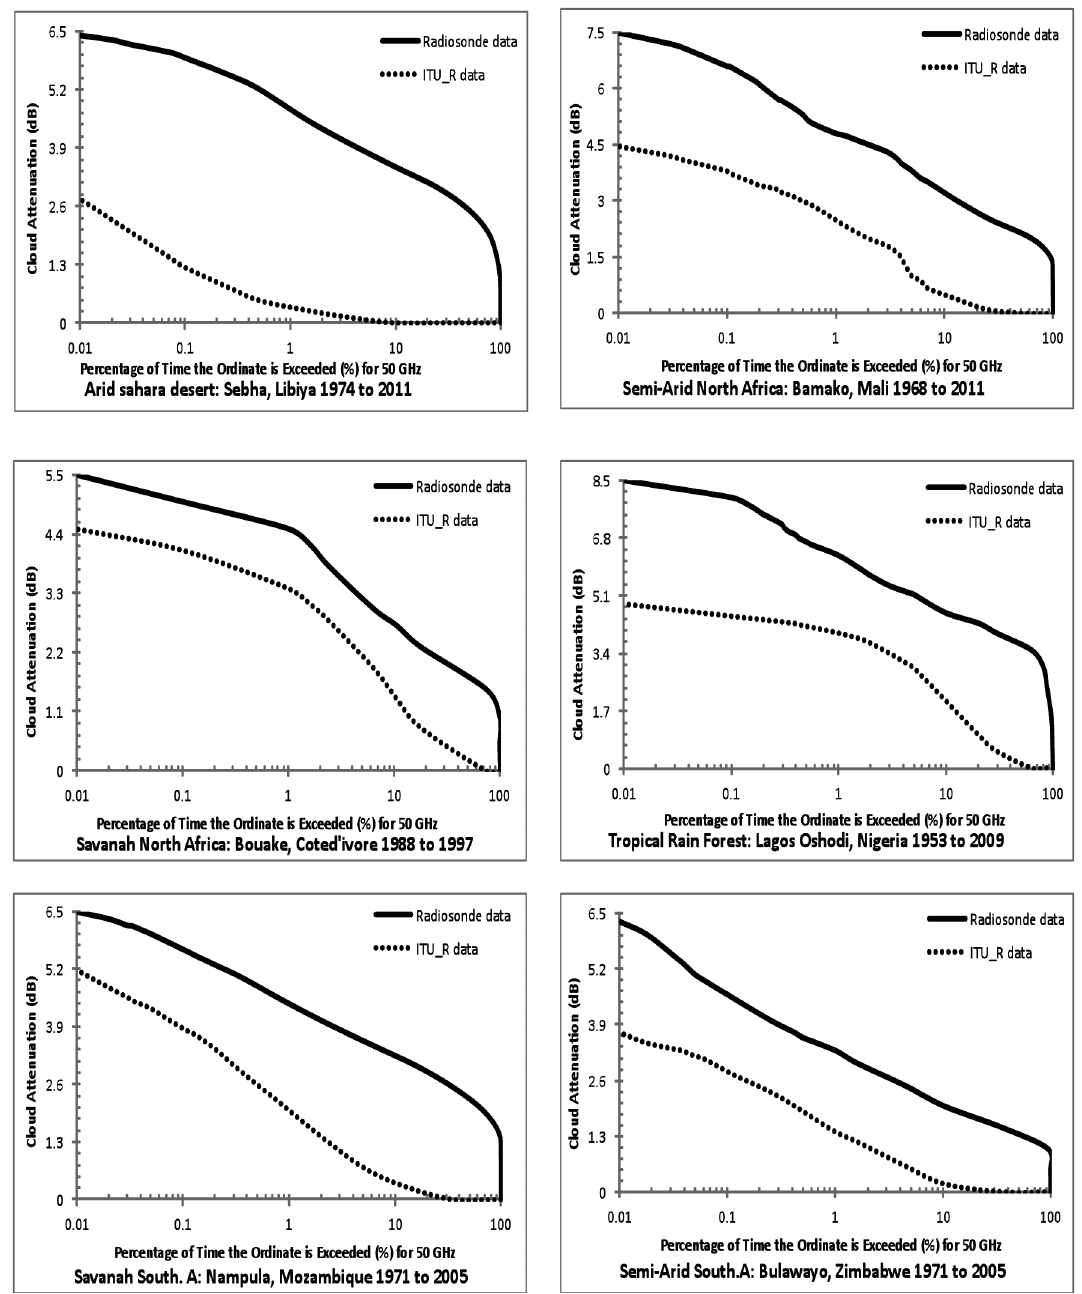
Figure 11. Cumulative distribution of cloud attenuation at 50 GHz obtained from radiosonde measurements. Also shown is the data obtained from the ITU-R model for the six major climatic zones of